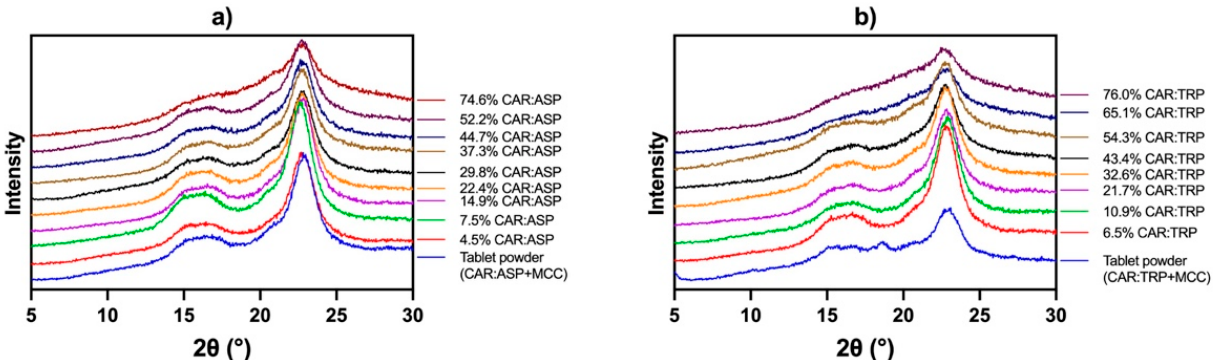
Figure 6. X-ray powder diffractograms of crushed ( a ) CAR:ASP tablet formulations (%, w / w ) and powder mixture and ( b ) CAR:TRP tablet formulations (%, w / w ) and powder mixture. Intensity off-set to enhance comparability.